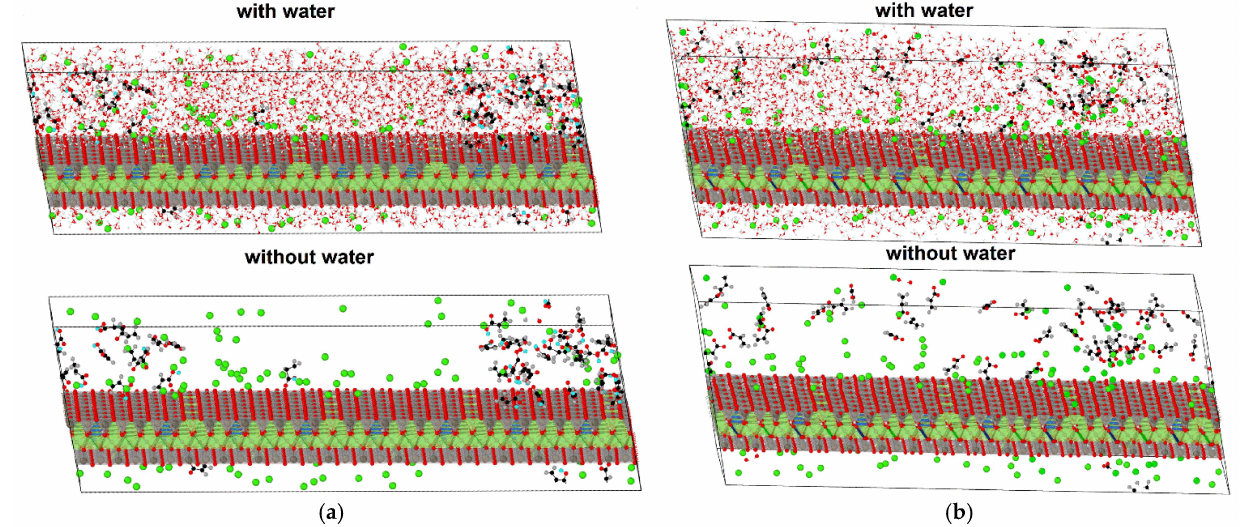
Figure 6. Systems in 63.00 ps after adding ( a ) acrylic acid and ( b ) sodium acrylate (figure shown without water molecules to improve